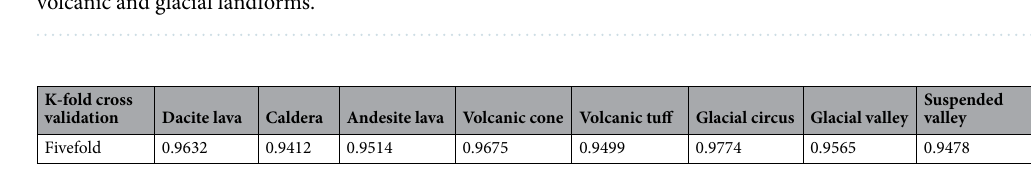
Table 10. Results of loss and accuracy operations estimated using the Python based Spyder software for volcanic and glacial landforms.